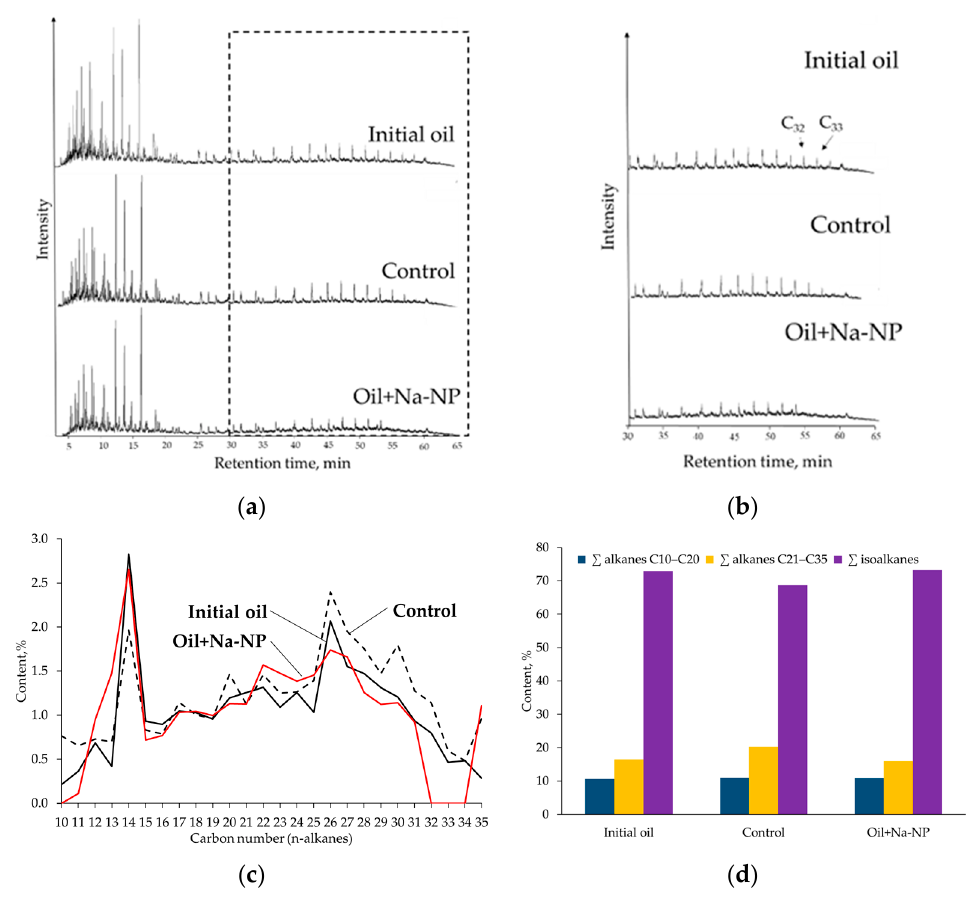
Figure 6. GC-MS of saturated hydrocarbons. C10–C32—the number of carbon atoms in n-alkanes;